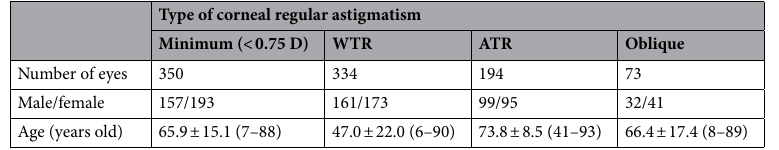
Table 1. Background data of patients. D: diopter, WTR with-the-rule, ATR against-the-rule, mean ± standard deviation